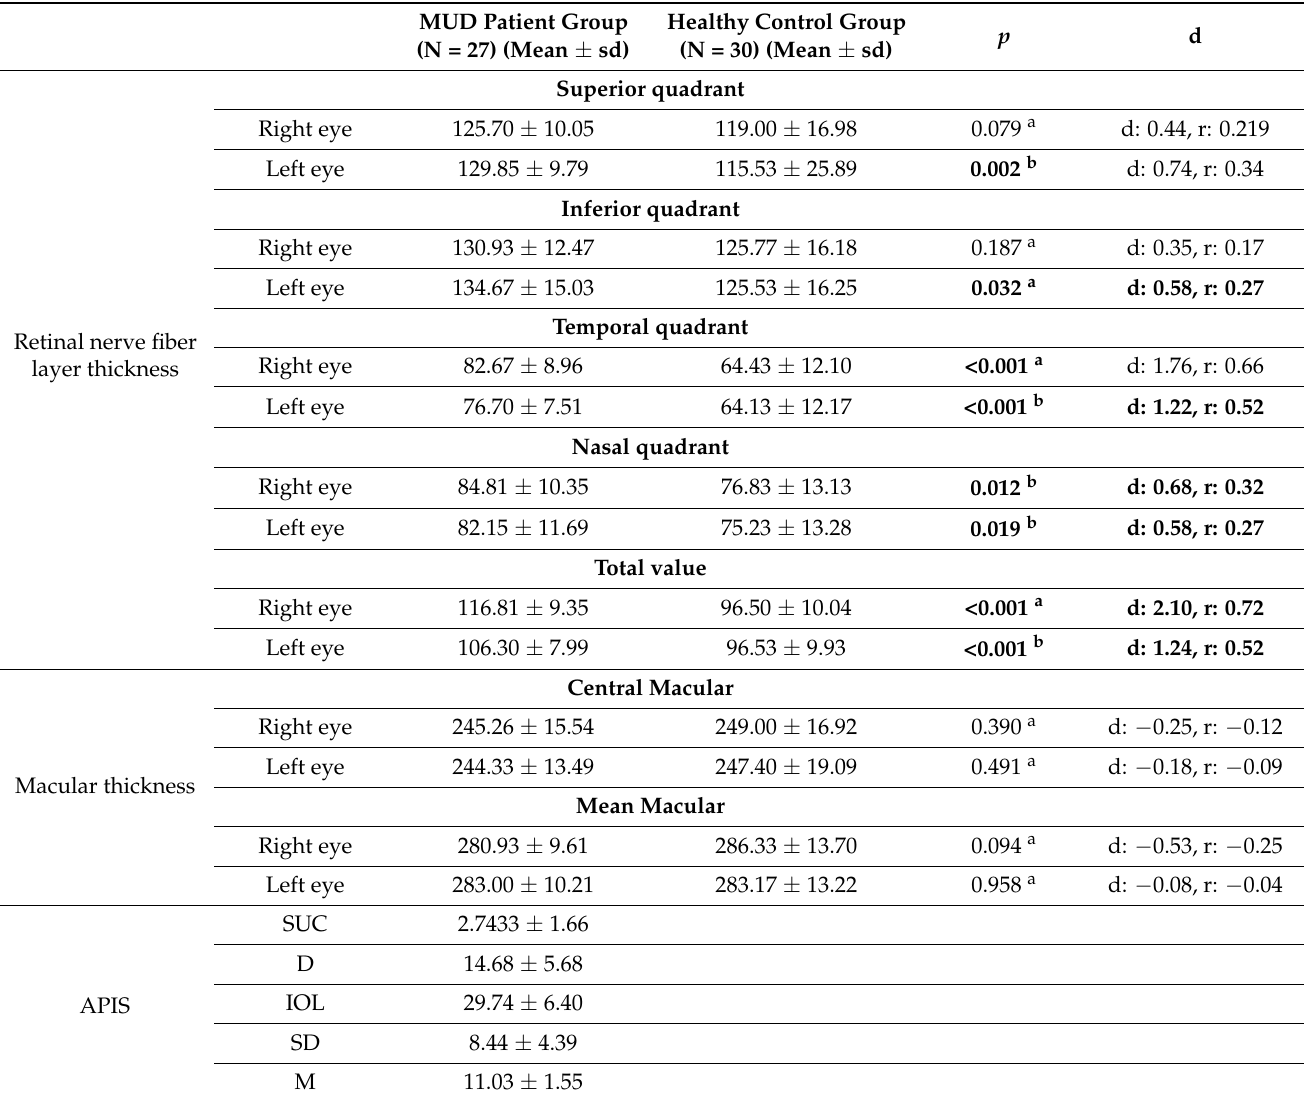
Table 2. Retinal nerve fiber layer thickness evaluated by optical coherence tomography. MUD Patient Group Healthy Control